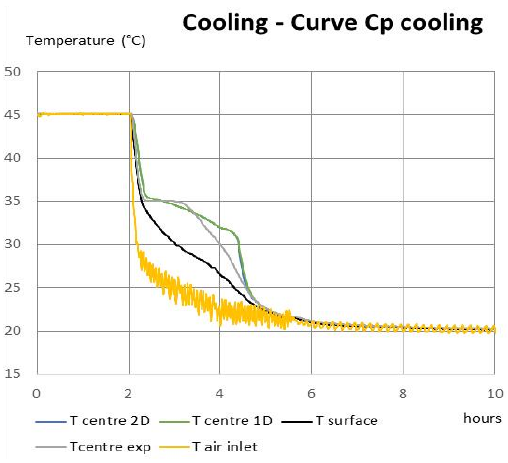
Figure 16. Temperature variation at the centre of the container. Heating case with the heating c p curve.